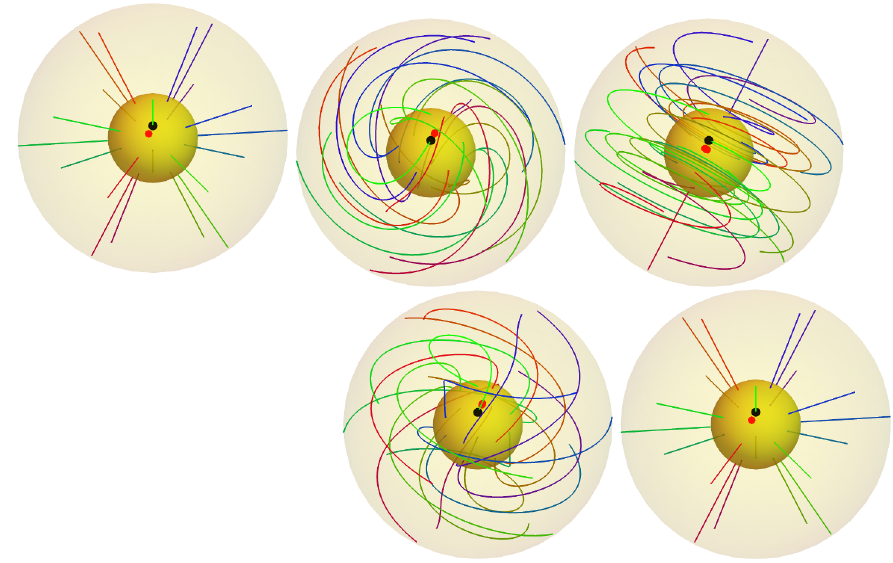
Figure 1. The small yellow sphere is connected to the surrounding by wires. If this sphere is rotated as indicated by the red dot, around the axis passing through the black dot, the wires get increasingly entangled up to rotations by 2 π and disentangled again when approaching 4 π